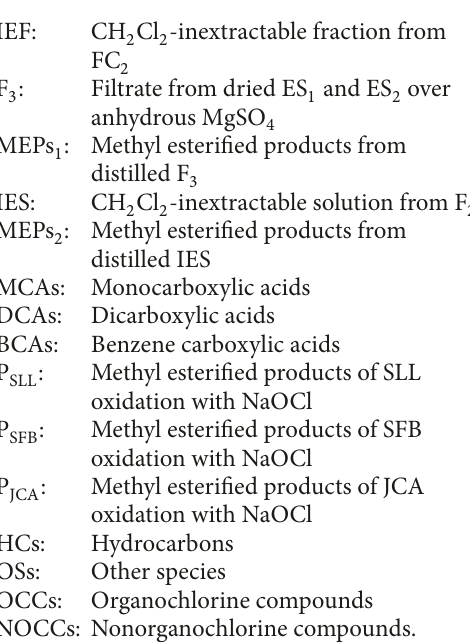
Figure S2: total ion chromatograms of P SFB . Figure S3: total ion chromatograms of P JCA . Table S1: MCAs detected in the products from coal oxidation. Table S2: DCAs detected in the products from coal oxidation. Table S3: BCAs detected in the products from coal oxidation. Table S4: HCs detected in the products from coal oxidation. Table S5: OSs detected in the products from coal oxidation. (Supplementary